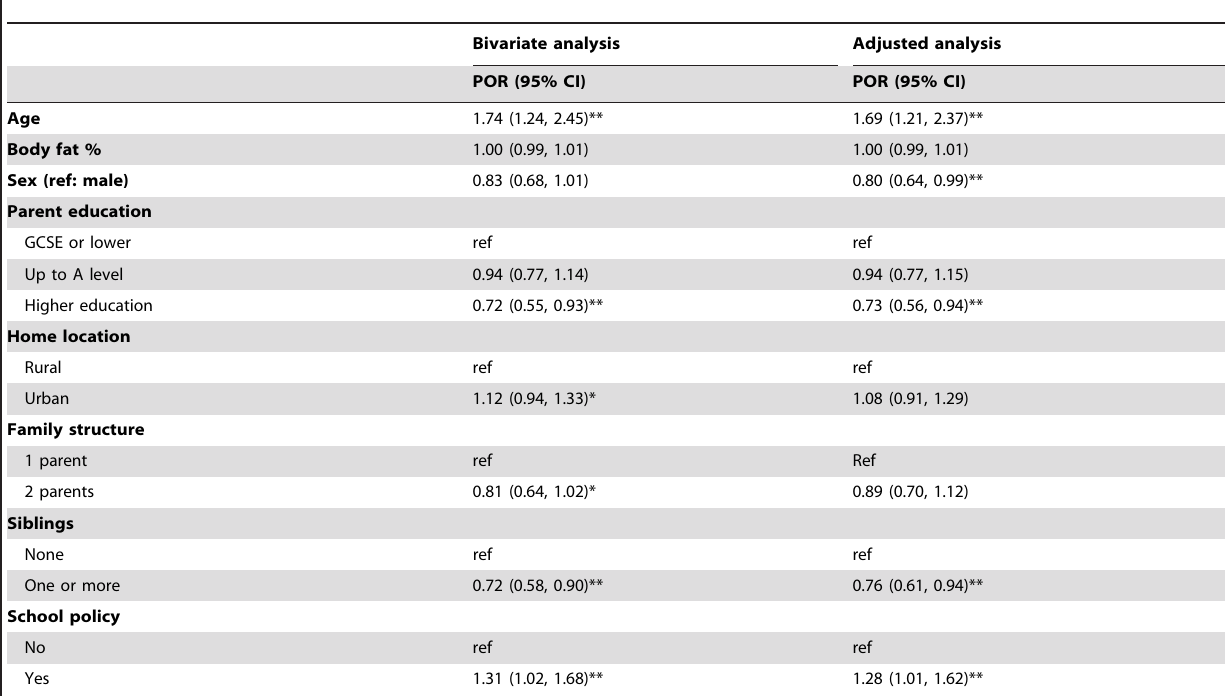
Table 3. Association of anthropometric and socio-demographic characteristics with health behaviour risk score (No. of unmet guidelines)